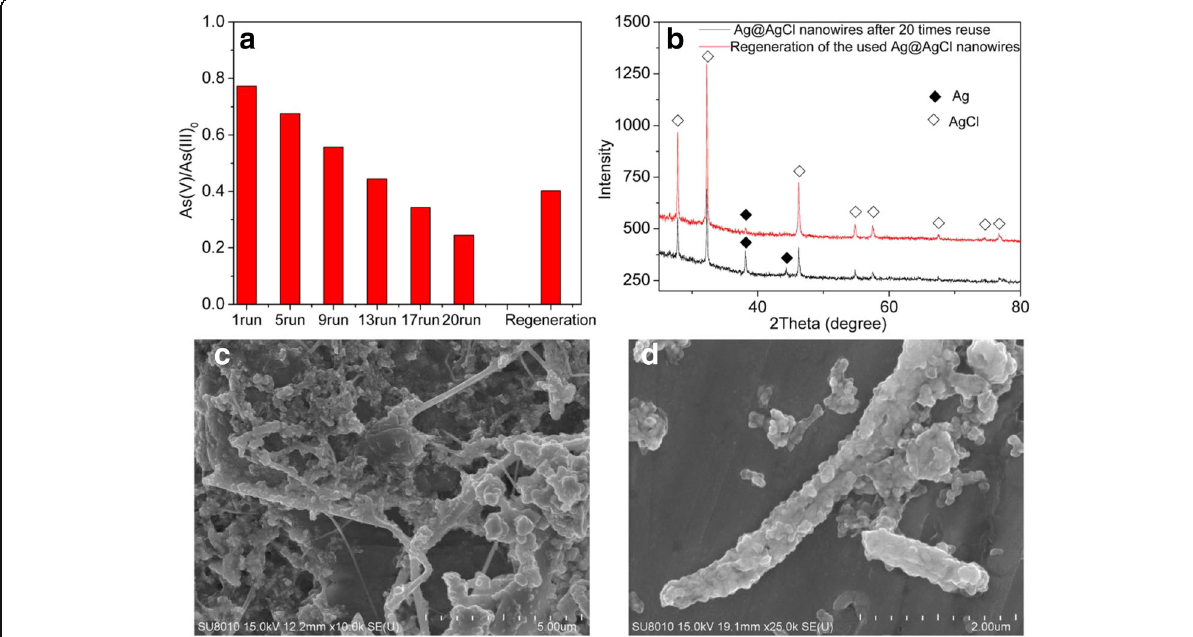
Fig. 9 a Photostability test of the Ag@AgCl for 20 cycles and regenerated Ag@AgCl. b XRD patterns of Ag@AgCl after the 20th cycle and regenerated Ag@AgCl. c SEM images of Ag@AgCl after the 20th cycle. d SEM images of regenerated